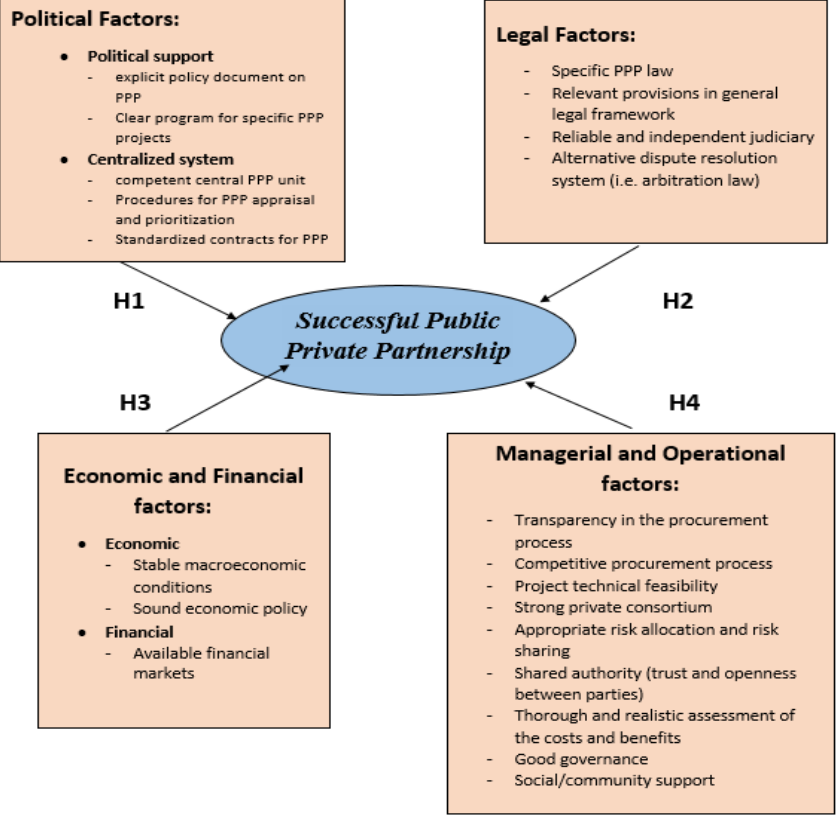
Figure 1. Research conceptual framework.